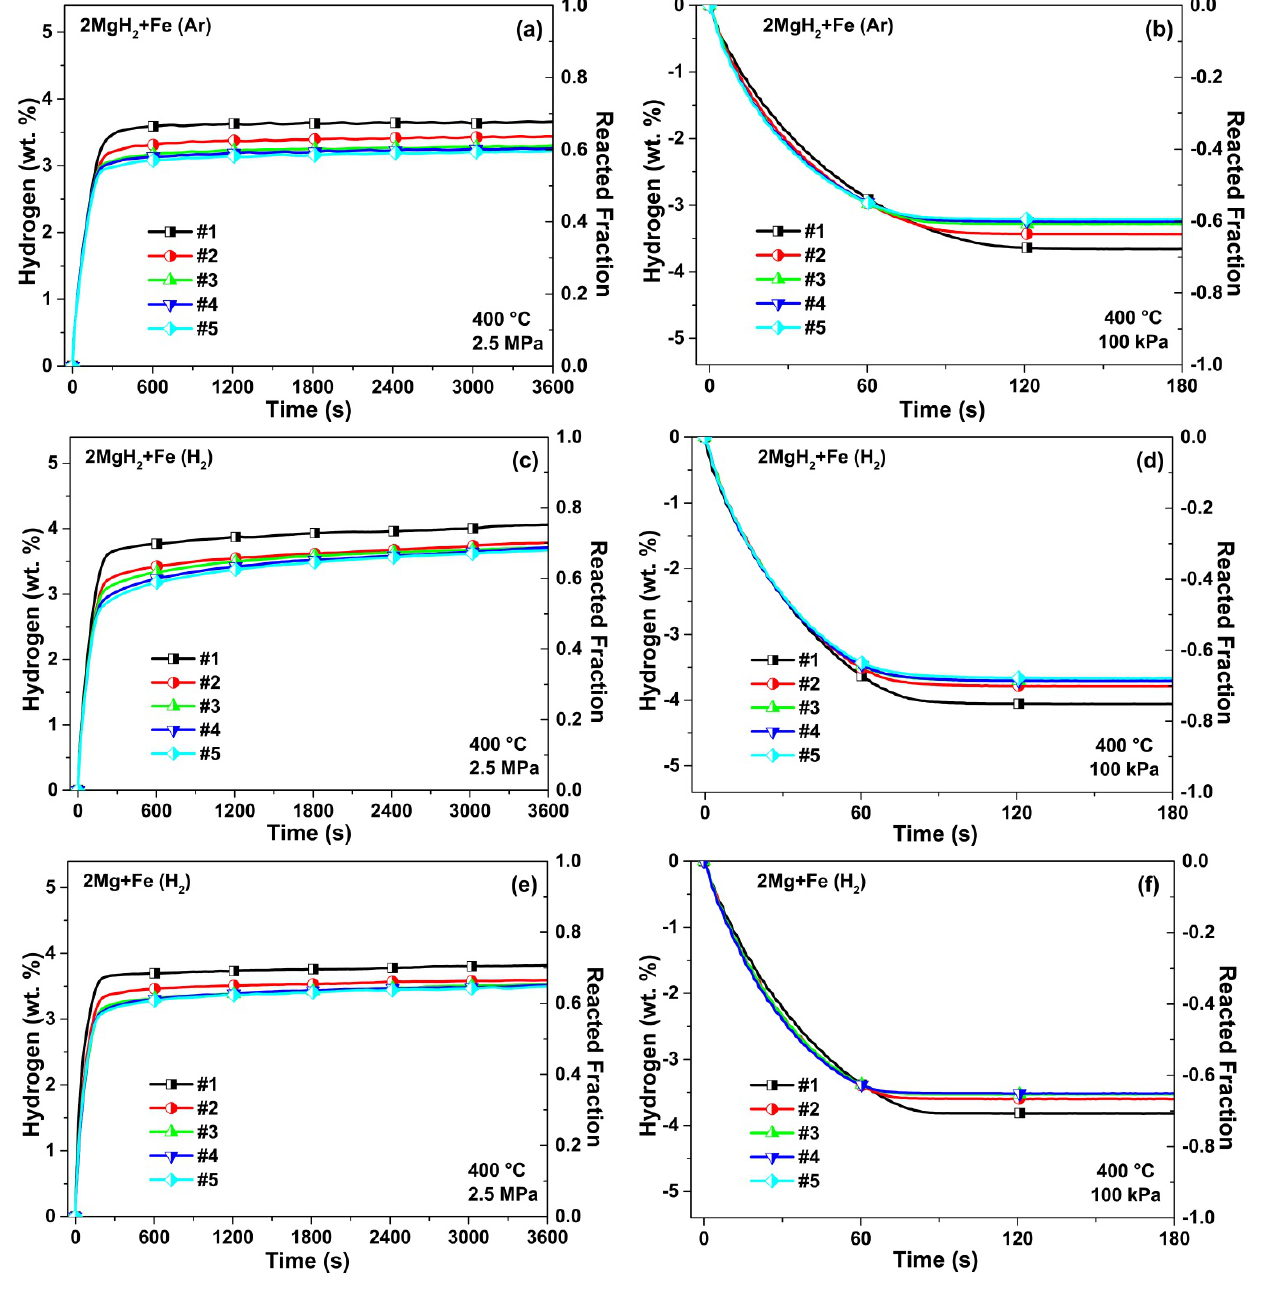
+ Fe (H ) and ( e ) and 2 2